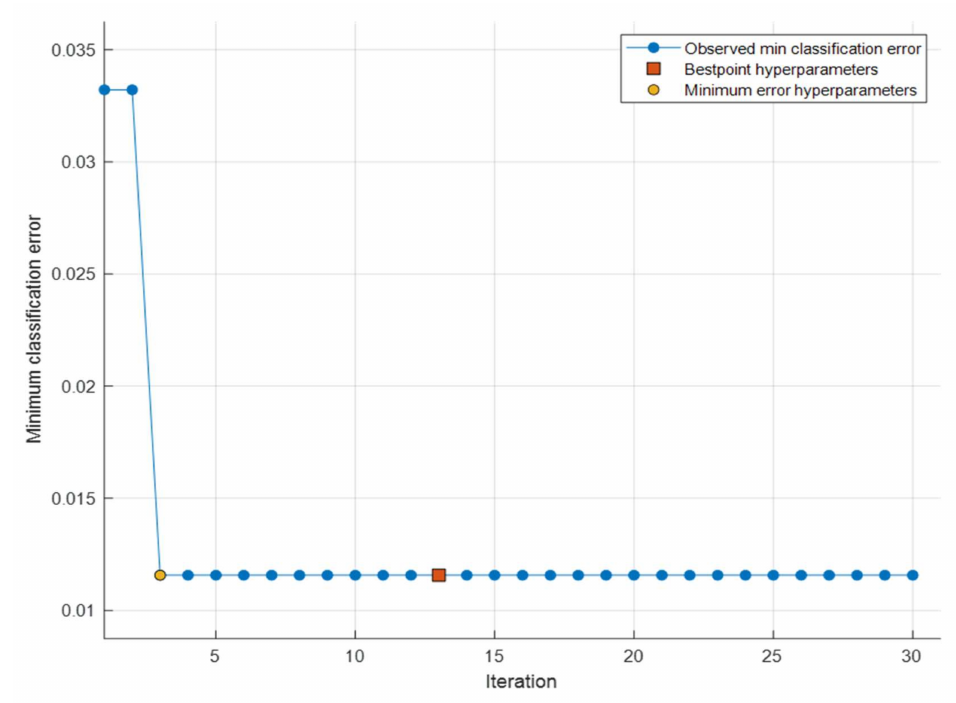
Figure 7. Minimum classification error vs. learning iterations.